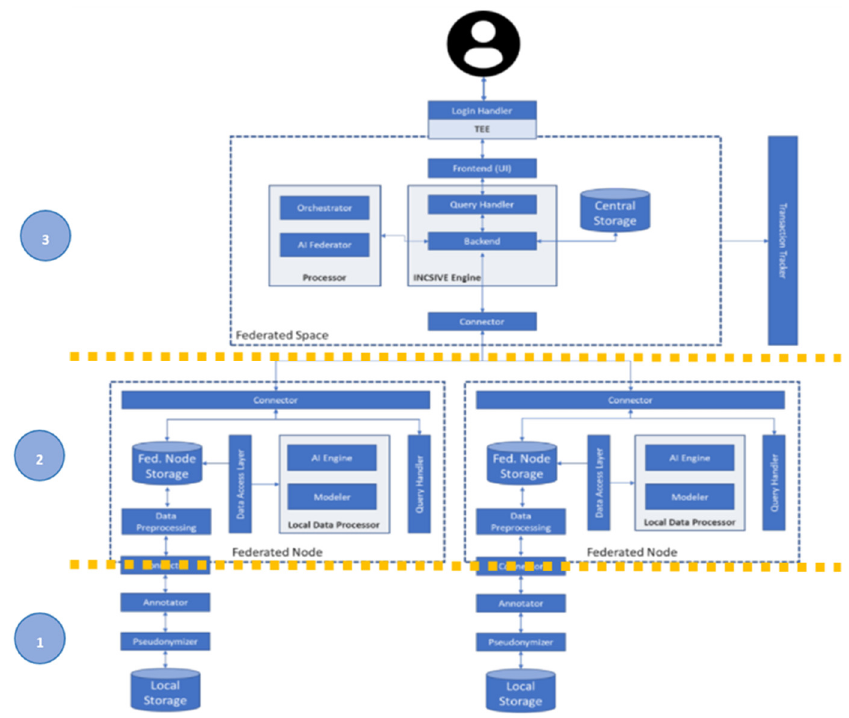
Figure 7. INCISIVE preliminary architecture.